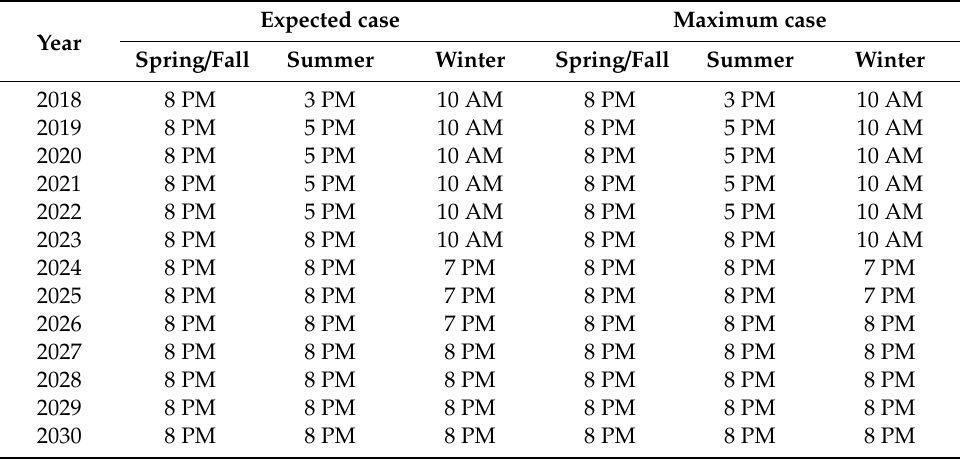
Table 21. Peak load time by season from 2018 to 2030 considering PV and EV penetration. Expected Year